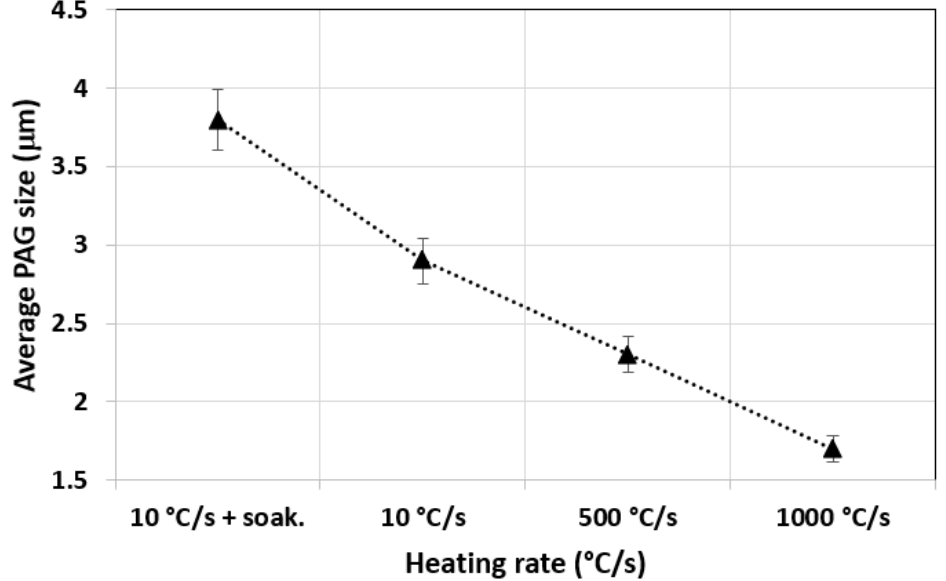
Figure 1. Effect of the heating rate increase on PAG size (data from [40]). Low/medium carbon steel (0.25 wt. % C), peak temperature of 850 °C, and cooling rate of 20 °C/s.